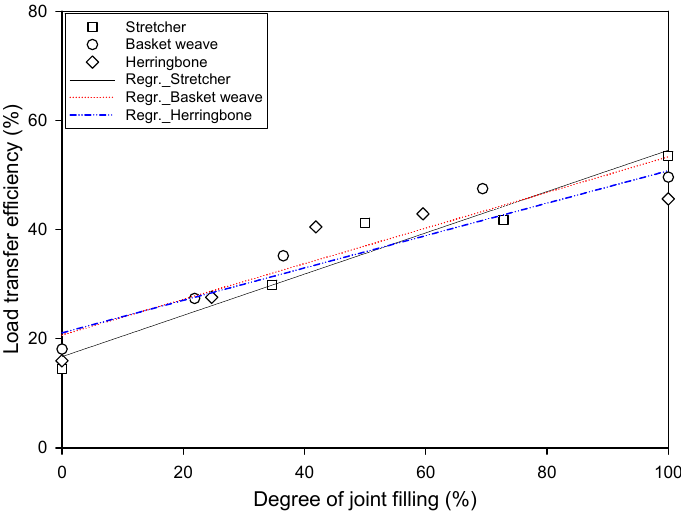
Figure 7. LTE according to lying patterns for the rectangular block.